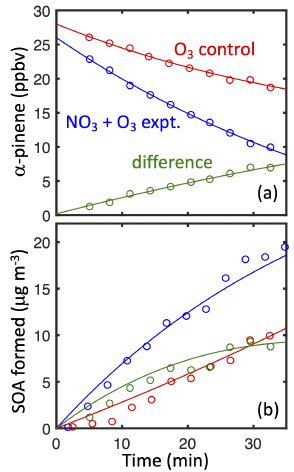
Figure 3. (a) α -pinene loss and (b) SOA formation in simulated nighttime experiment 22 (blue) and the ozonolysis control experi- ment (red). The difference (green) shows the contribution from α - pinene + NO 3 .